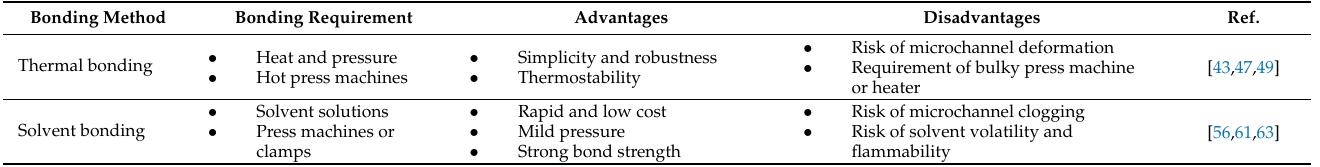
Table 1. Comparison of bonding methods for thermoplastic